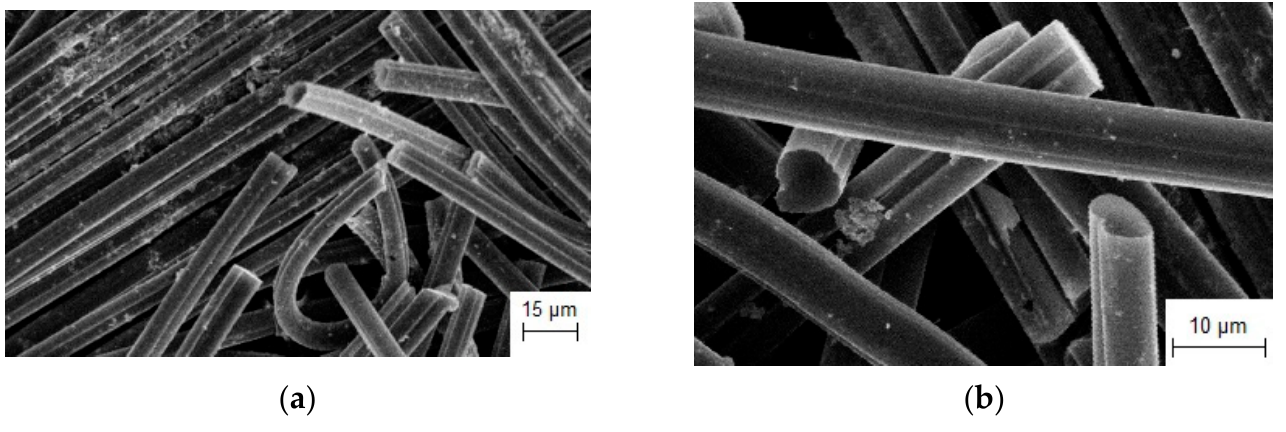
Figure 11. Micrographs of the niobium carbide-carbon fiber composite at different scale. ( a )—Overall view and ( b )—cross-sections of fibers. Synthesis conditions: CT in NaCl-KCl-K 2 NbF 7 (30 wt.%)–Nb melt at 1123 K for 24 h.